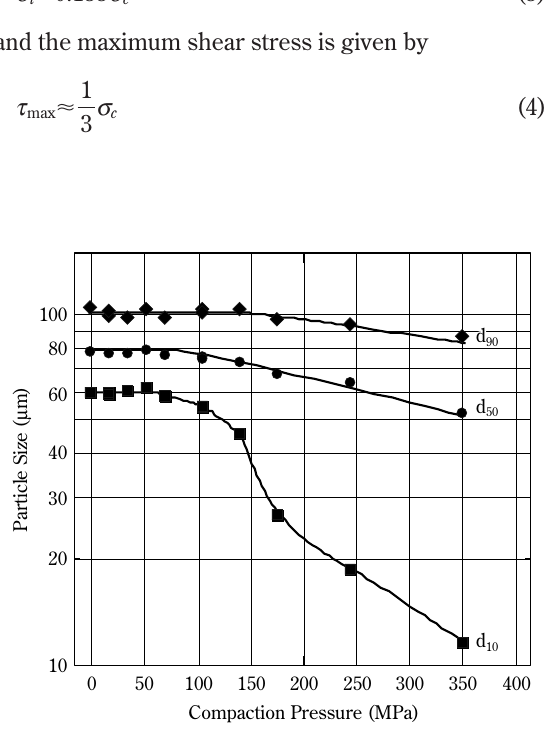
Fig. 5 During compaction, the median size of the distribution ( a 50 ) and the fine end of size distribution ( a 10 ) begin to decrease in size at about 60 MPa ( (cid:1) P y /3). The coarse end of size distribution ( a 90 ) begins to change near P y ( (cid:1) 150